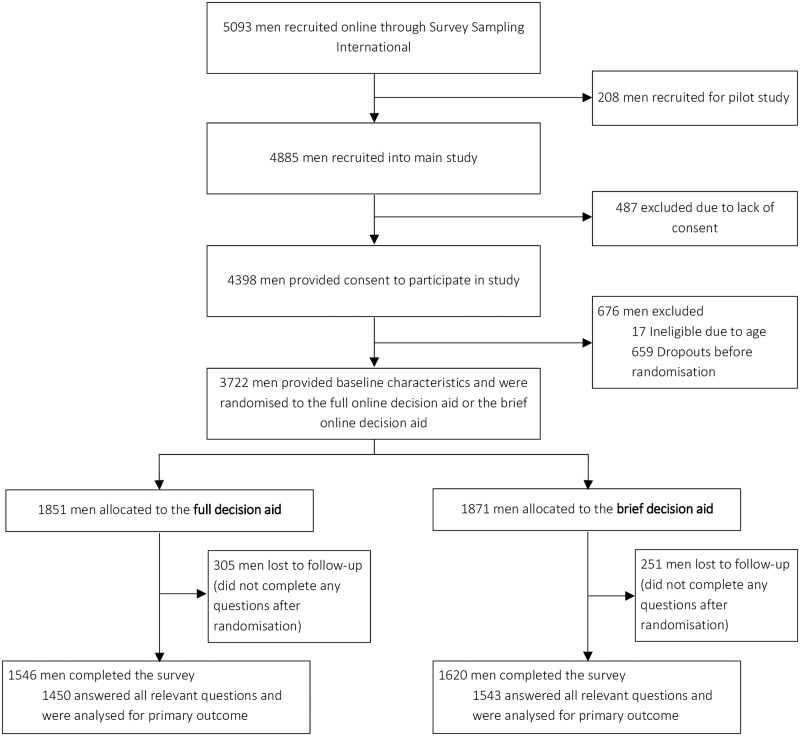
Study flowchart.